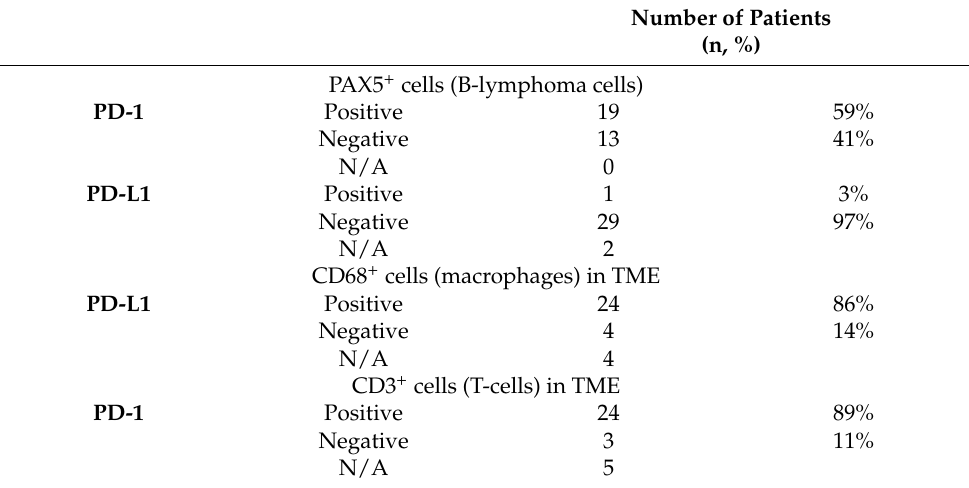
Table 2. Expression of PD-1 and PD-L1 in patients with de novo DLBCL.